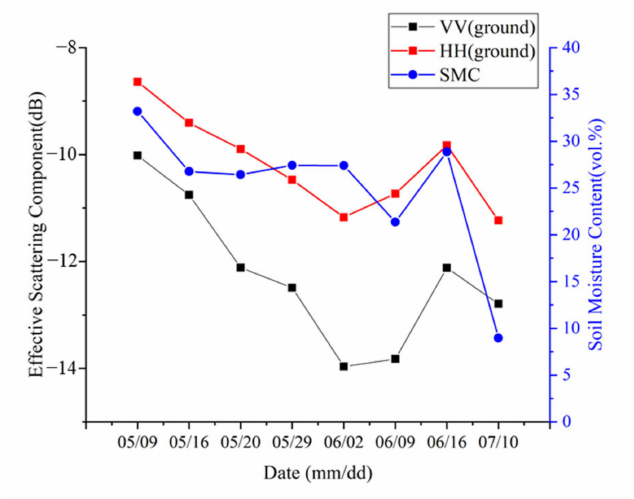
Figure 12. Mean value of effective surface scattering and mean value of measured soil moisture.